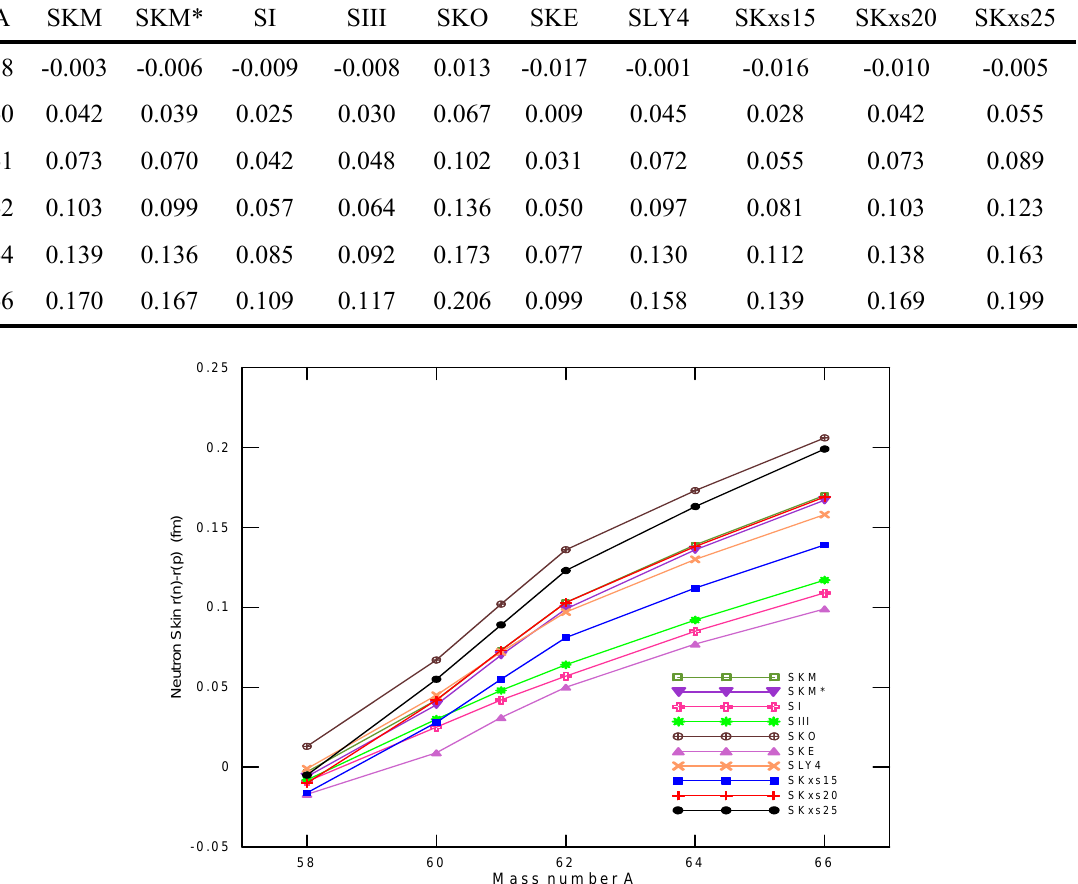
Fig. 5: The neutron skin thickness for 58-66 Ni